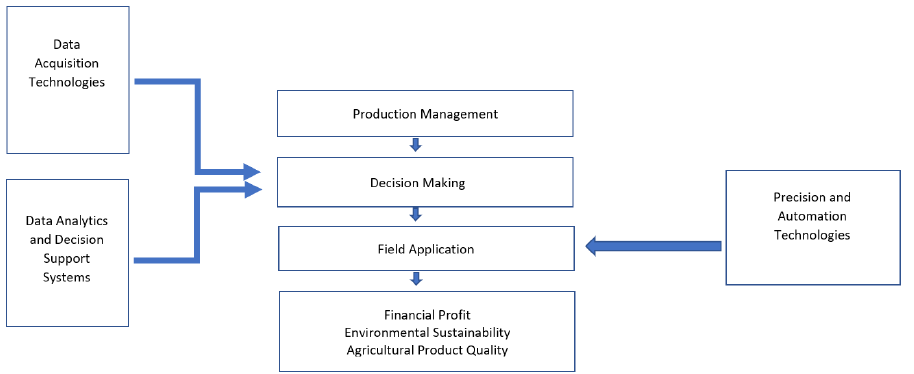
Figure 1. The smart farming processes.